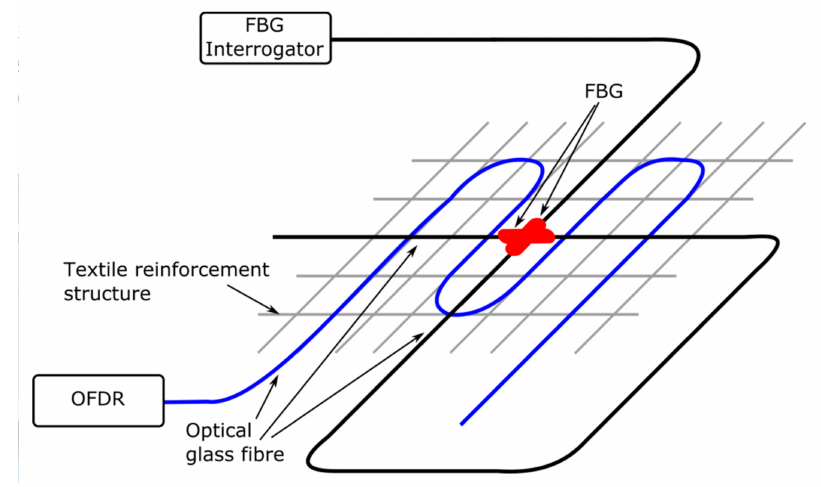
Figure 1. Sketch of the FCS samples for testing under practical conditions.